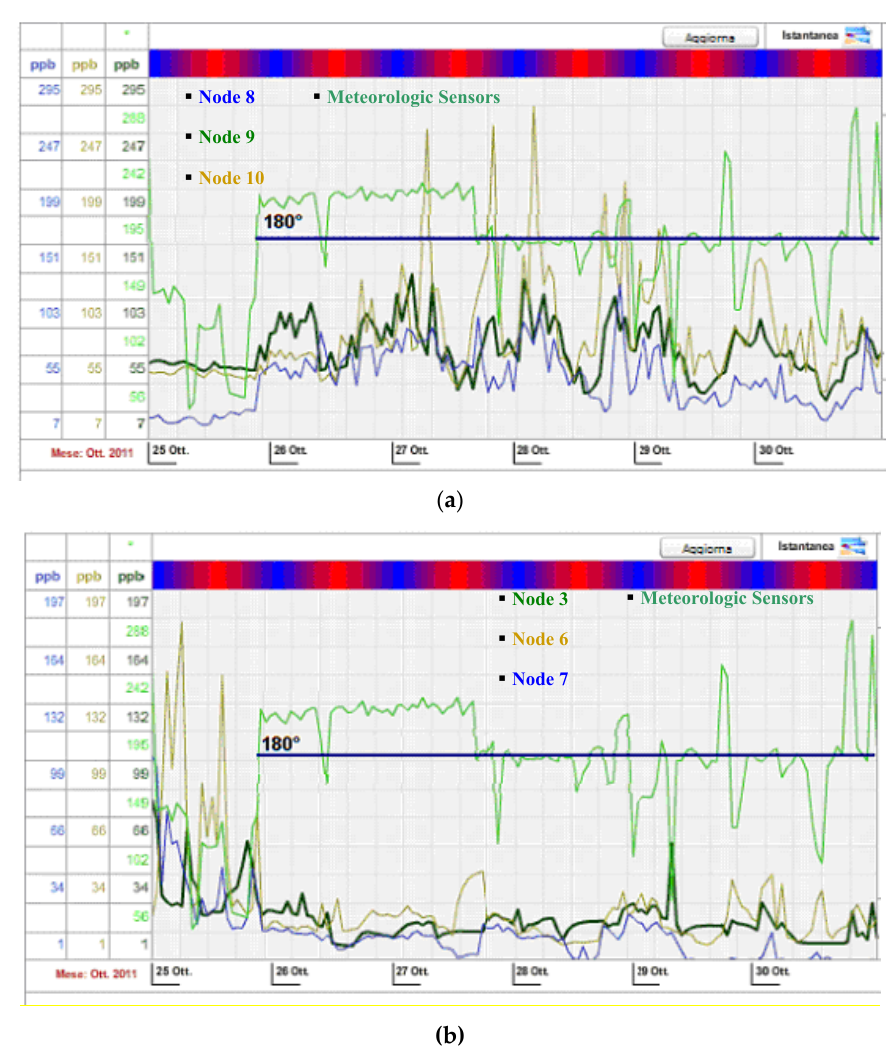
Figure 10. Layout of the six VOC detectors located around a chemical plant in Mantova.